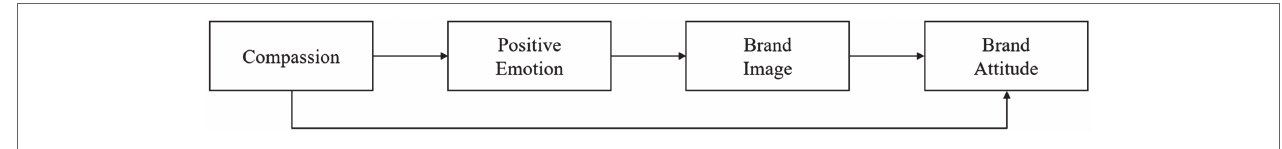
FIGURE 1 | Conceptual